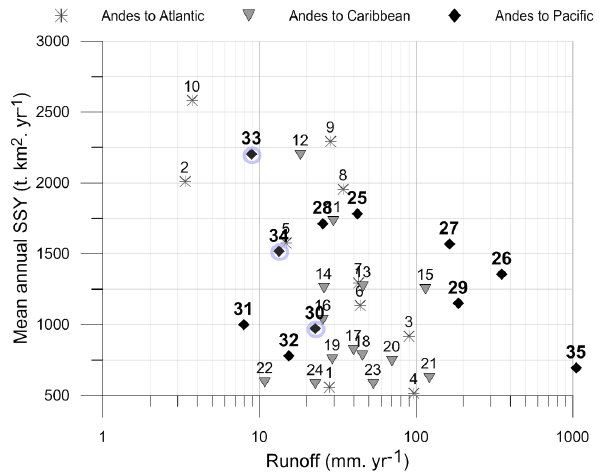
Fig. 11. Relations between suspended sediment yield (SSY) from various sources (see Table 3) and runoff for several mountain rivers in the South American Andes. The Santa (32), Tablachaca (33) and Condorcerro (34) rivers, from this study, are circled.